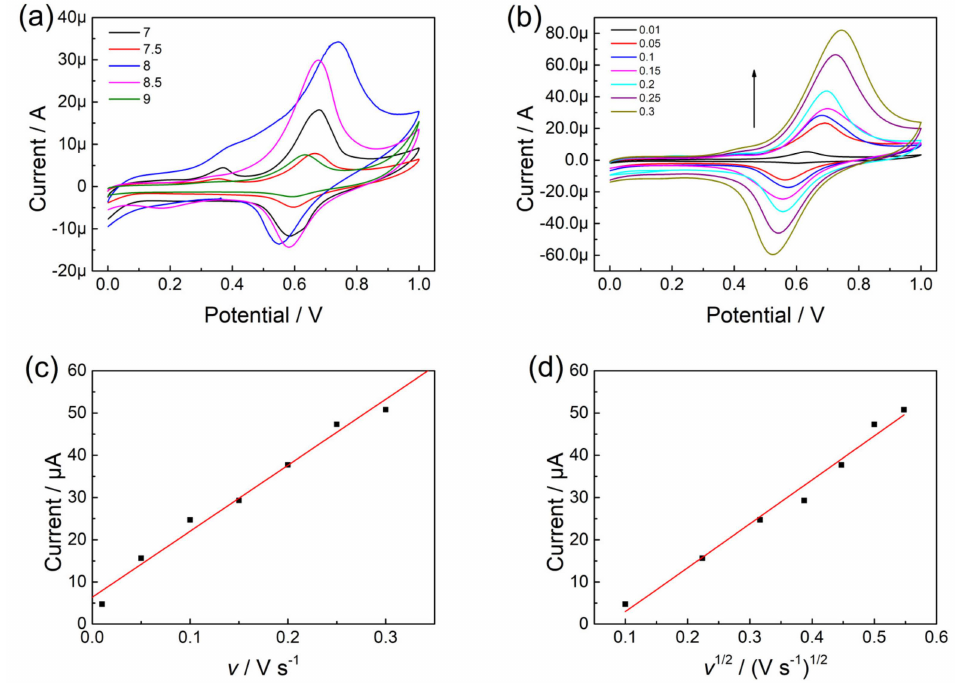
Figure 4. ( a ) Effect of pH on CV curves of olivetol; ( b ) CV curves of p-L-serine/CuO/CPE in olivetol at different scan rates; ( c ) The linear graph of peak currents and scan rates; ( d ) The linear graph of peak currents and (scan rates) 1/2 .